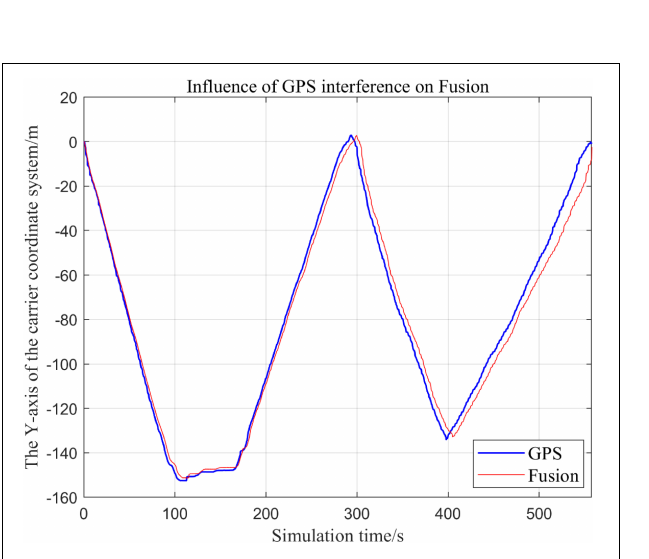
FIGURE 23 | Comparison of the overall trajectory of the output x -axis with different